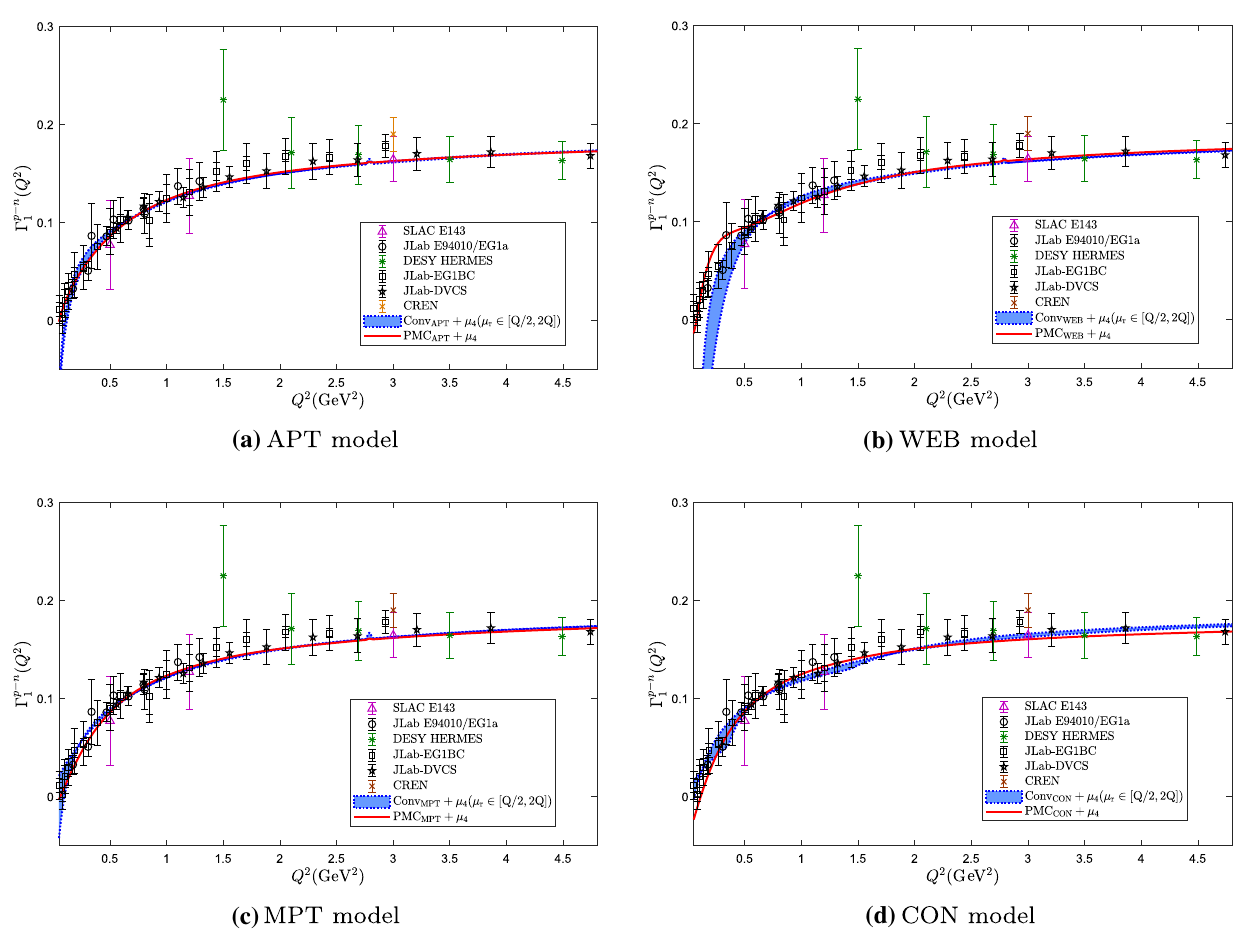
− n ( Q 2 ) with both leading-twist Fig. 5 The spin structure function (cid:3) p N 3 LO level and N 4 LO level before and after applying the PMC scale- 1 and the “massive” high-twist contributions under four α s models: a the setting approach, respectively. The shaded band shows the prediction under conventional scale-setting approach by varying μ r ∈ [ Q / 2 , 2 Q ] . APTmodel; b theWEBmodel; c theMPTmodel;and d theCONmodel. The leading-twist perturbative contributions have been calculated up to The solid line is the scale-invariant PMC